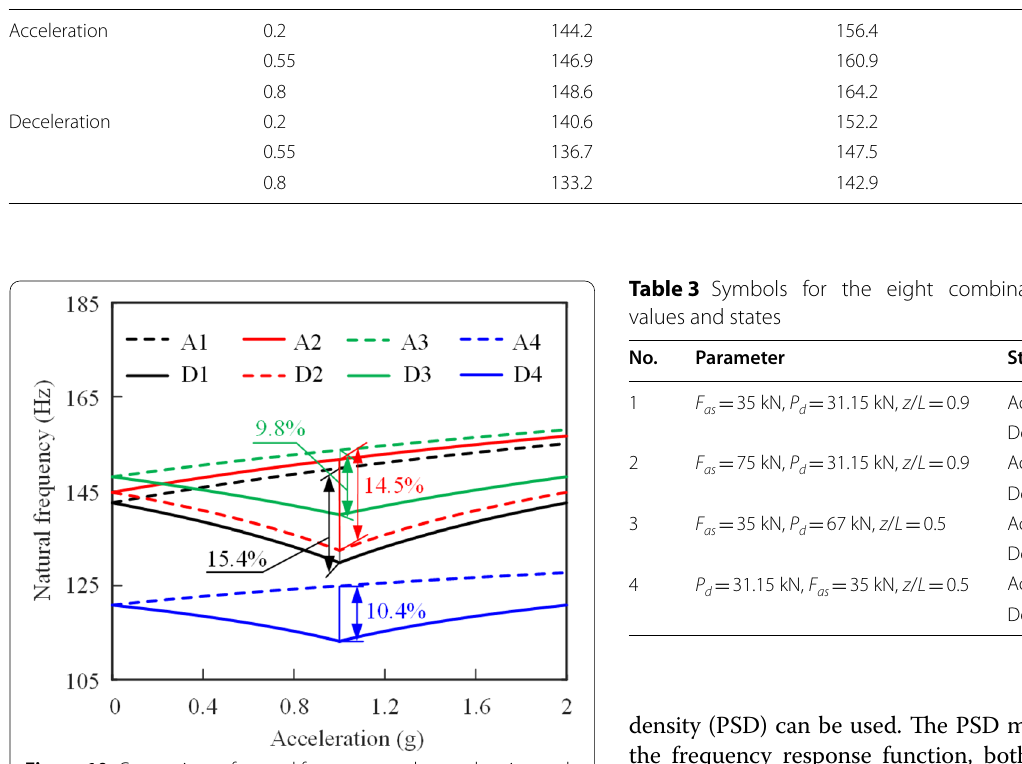
Table 2 Comparison of the experimental and theoretical natural frequency values of the system Mode